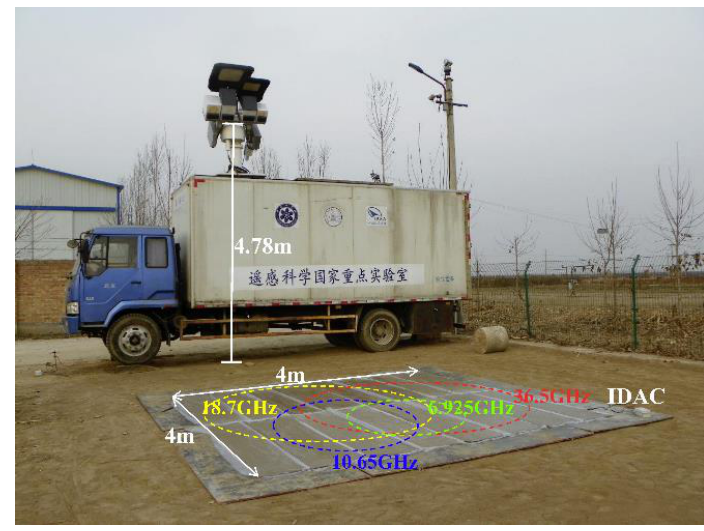
Figure 1. Viewing scene of the truck-mounted multi-frequency microwave radiometer (TMMR).